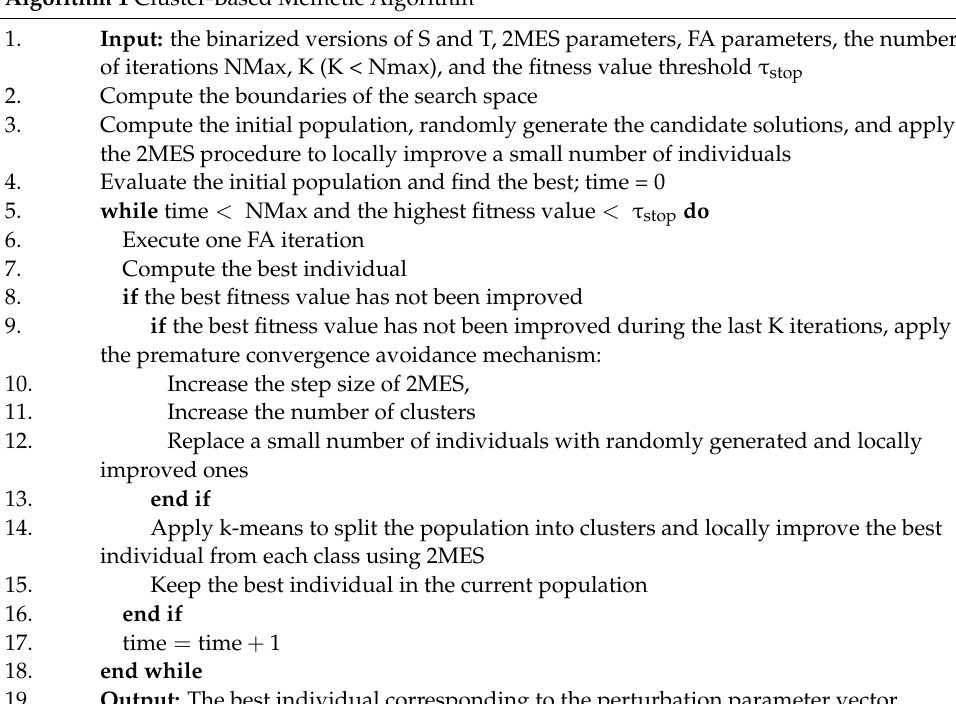
Algorithm 1 Cluster-Based Memetic